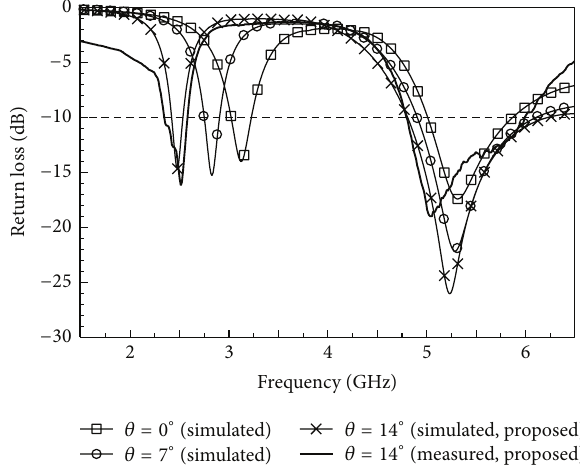
Figure 2: Simulated and measured return loss versus frequency for various 𝜃 .